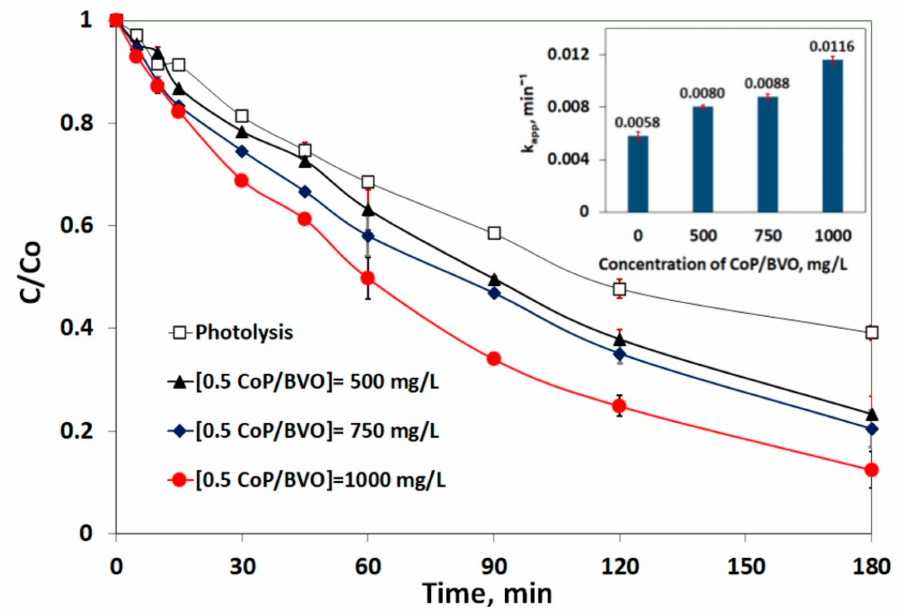
Figure 5. Effect of 0.50CoP/BVO concentration on SMX destruction. [SMX] = 500 µ g/L, pH = 5.5, UPW. Inset: Apparent rate